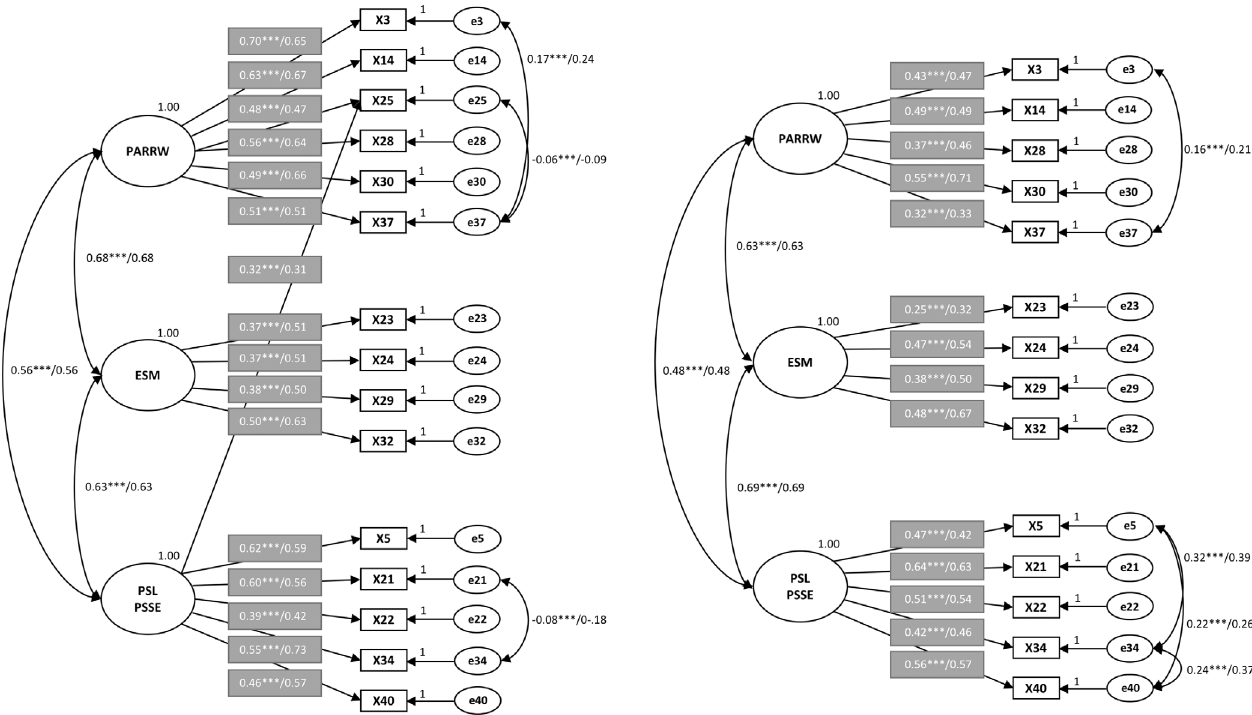
FIG. 2. Path diagrams for the CFA of Douglas et al. [11] (left) and the new model (right). The gray boxes contain the loadings also represented by the arrows. Two headed arrows represent the correlations of the constructs and residual correlations of the items. The variances of PARRW, ESM, and PSL and of the errors are set to one. The values behind the slashes are